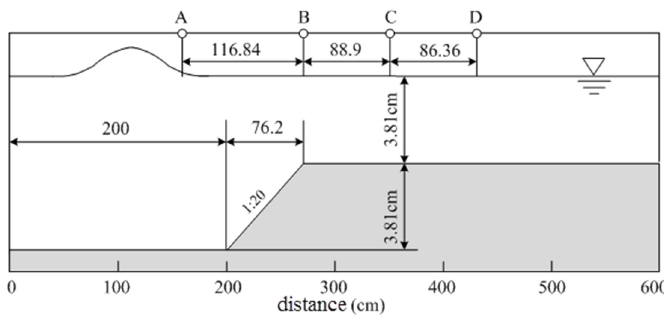
Figure 7. Sketch of the experiment setup of Madsen.